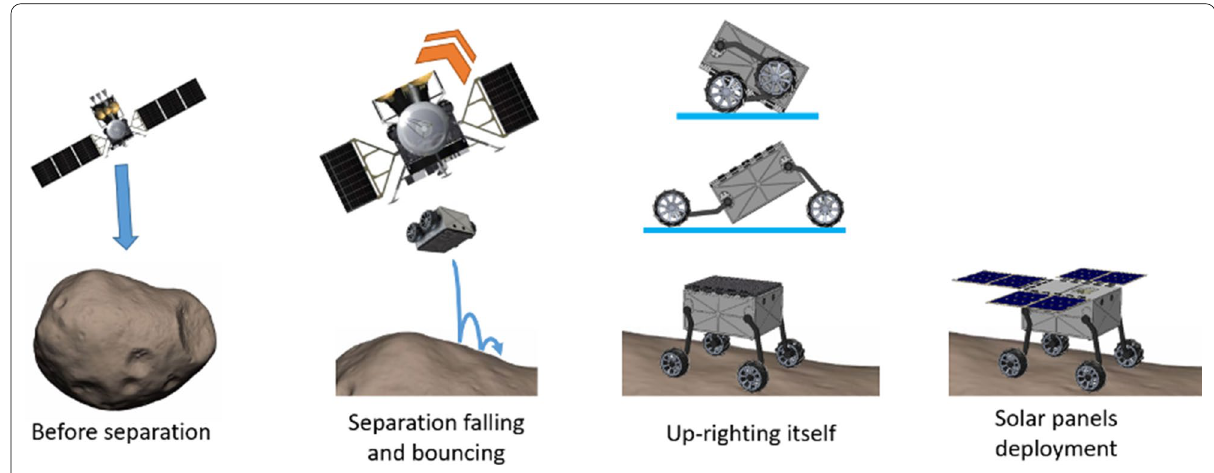
Fig. 16 Rover delivery to the Phobos surface and up‑right strategy